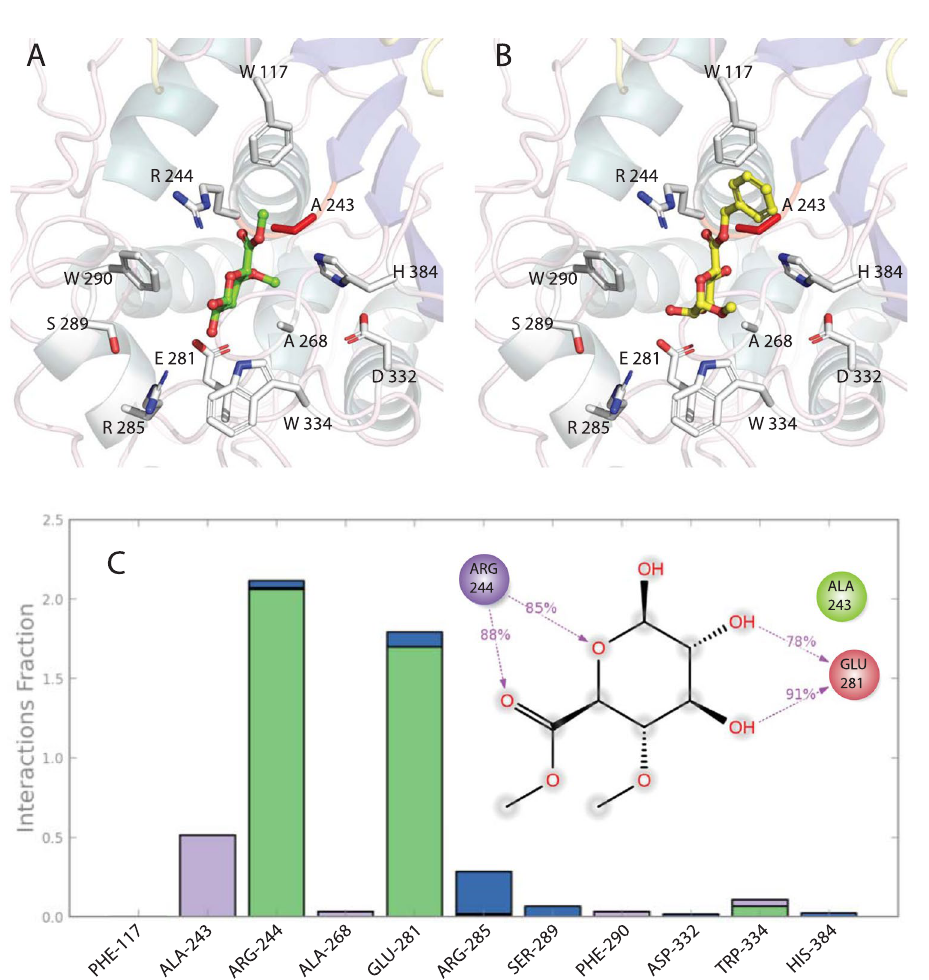
Figure 5. Structure of MZ0003 with ( A ) Methyl 4 -O- methyl-D-glucopyranuronate and ( B ) benzyl (methyl a-D-glucopyranoside) uronate docked into the catalytic site. ( C ) ligplot diagram and plot showing predicted fraction of interactions between methyl 4 -O- methyl-D-glucopyranuronate and MZ0003 during a 10 ns MD simulation in 0.5 M NaCl. Green indicates hydrogen bonds, violet hydrophobic interactions, and blue ionic